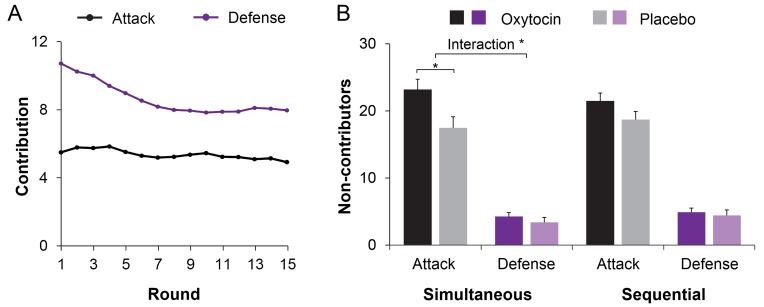
Oxytocin modulates contributions to group fighting.(A) Attackers contribute less than defenders, especially in early rounds (range 0–20). Curves were smoothed with a moving average window of three investment rounds. (B) Giving individuals oxytocin rather than placebo increases the number of non-contributing members in attacker groups especially under simultaneous decision-making (with 0–3 members per round across 15 rounds; range 0–45; displayed M ± 1 SE). Connectors indicate significant difference, with *p<0.05.